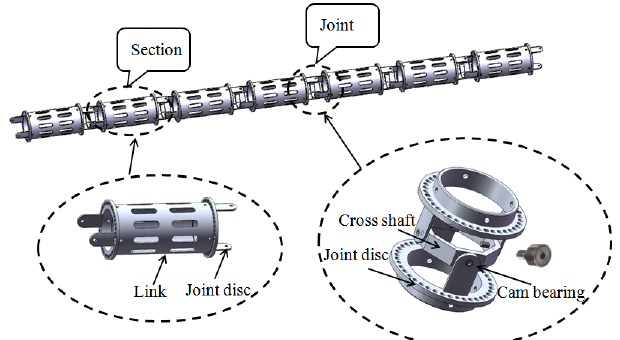
Figure 1. Manipulator